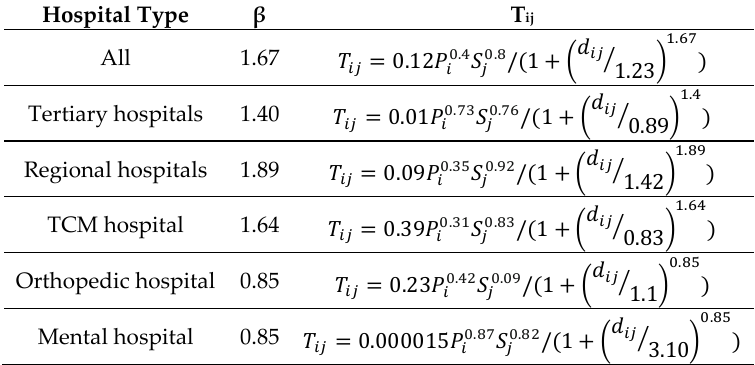
Figure 2. Inpatient distribution pattern among tertiary hospitals and regional hospitals captured by the fitted log-logistic function model. Int. J. Environ. Res. Public Health 2019 , 16 , x 8 of 11 Table 3. Estimated distance attenuation coefficient β and the inpatient distribution model for Table 3. Estimated distance attenuation coe ffi cient β and the inpatient distribution model for Shanghai.